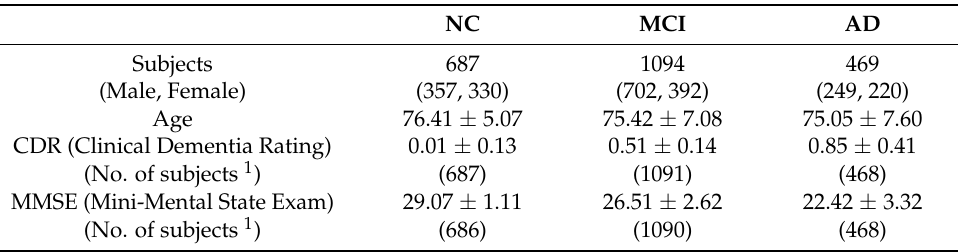
Table 1. Demographic information for NC (normal controls), MCI (mild cognitive impairment), and AD (Alzheimer’s disease) groups (N = 2250).